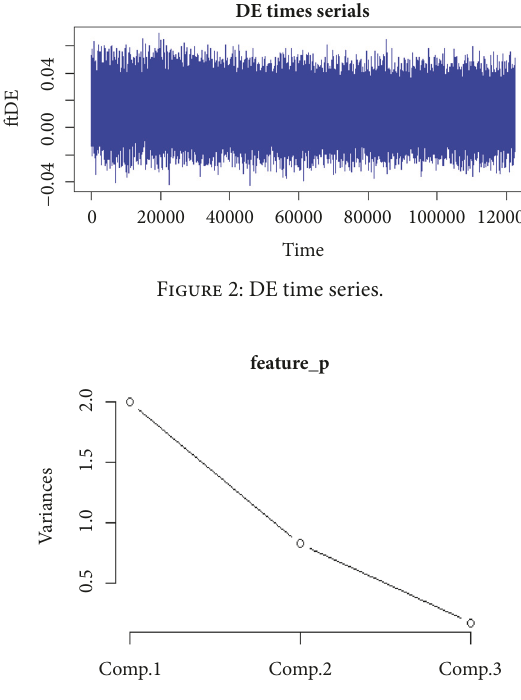
Figure 3: DE eigenvector principal component